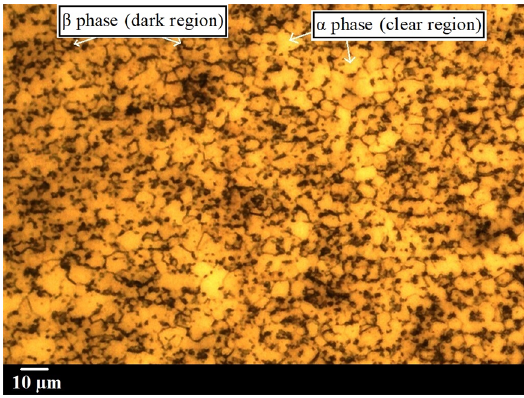
Figure 1. Optical microscopy of the Ti6Al4V cross